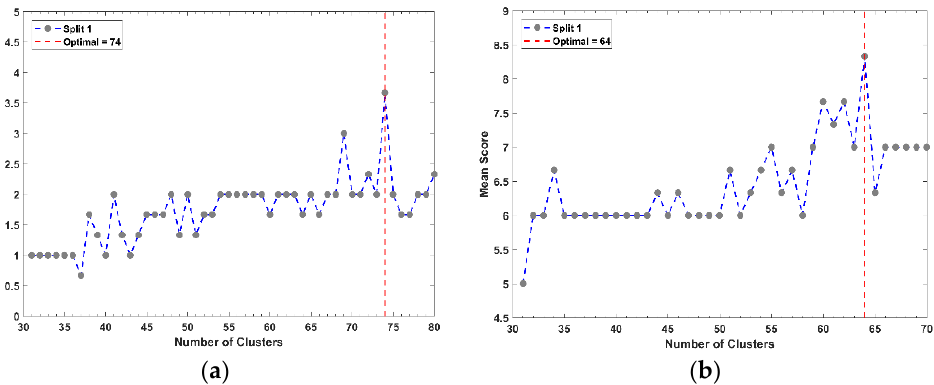
Figure 5. Example results from the determination of the optimal number of clusters for data reduction for (a) increment A and (b) increment B, for subset 1.